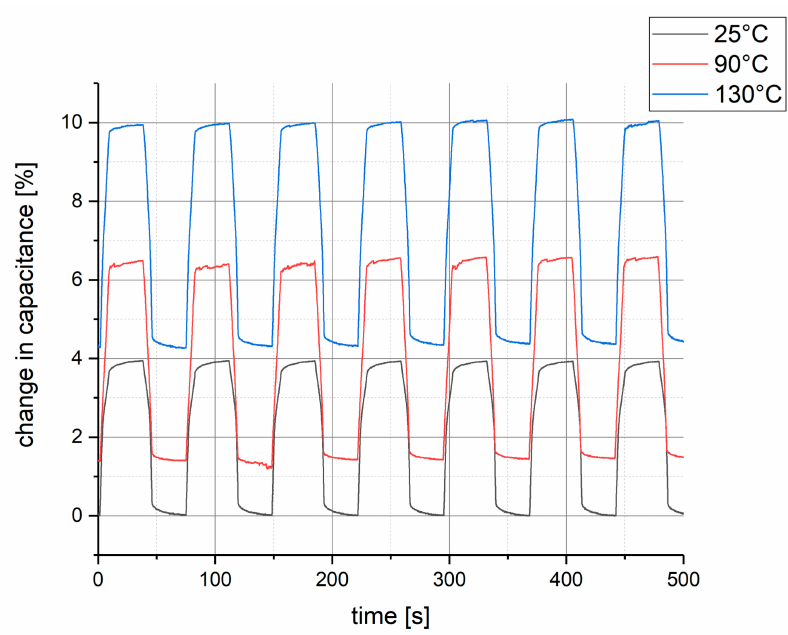
Figure 6. The change in capacitance as a function of time with pressure steps applied at three different temperatures: 25 ◦ C (black), 90 ◦ C (red) and 130 ◦ C